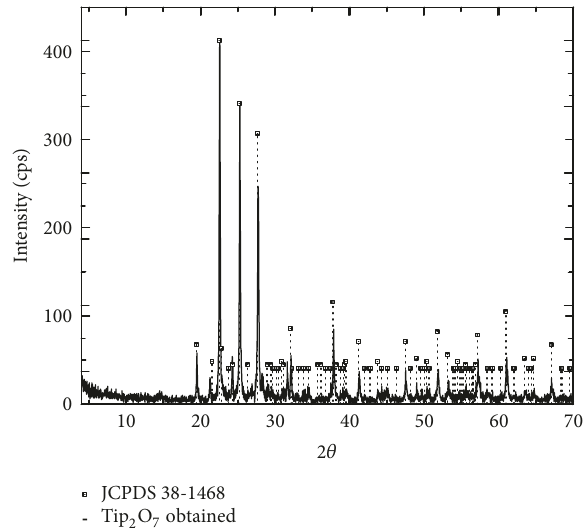
Figure 3: XDR spectra of the obtained material; the lines corre- spond to titanium pyrophosphate, pattern to JPCDS